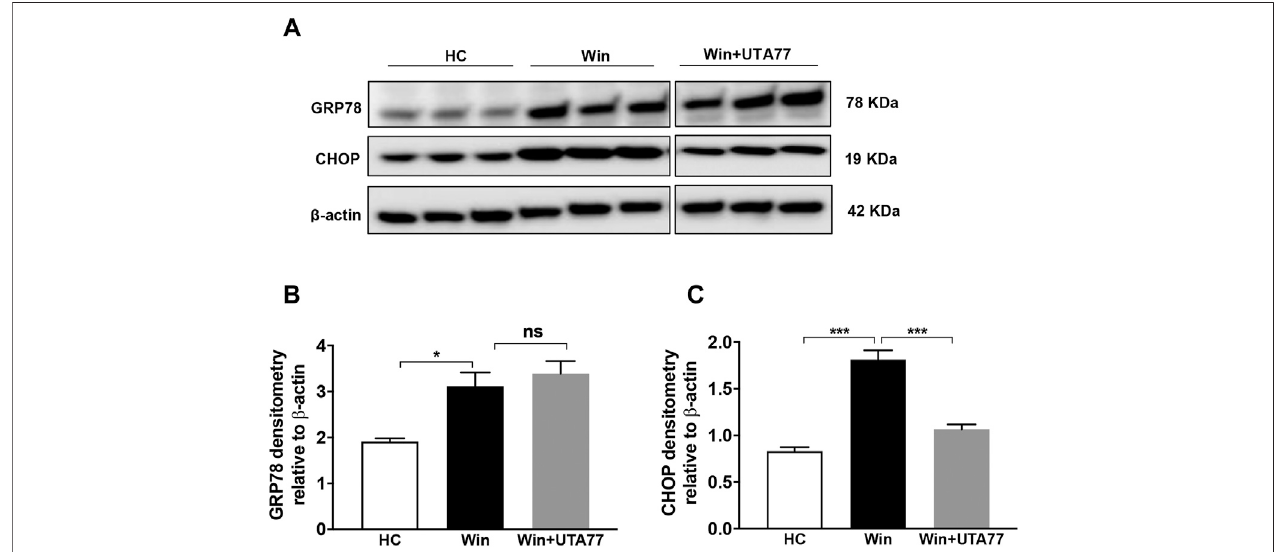
FIGURE 9 | Effect of UTA77 on endoplasmic reticulum stress (ER stress) markers in spontaneous chronic colitis in Winnie mice. (A) Protein levels of GRP78 and CHOP were analysed using Western blotting in distal colon. (B, C) Densitometry of GRP78 and CHOP. Bands densities were normalised to the levels of β -actin. Data expressed as mean ± SEM ( n (cid:1) 3/group) using one-way ANOVA followed by Tukey ’ s posttest, where *p < 0.05, ***p < 0.001, and ns: nonsigni fi cant. The controls used (HC and Win) in this fi gure have been published previously (Shastri et al.,